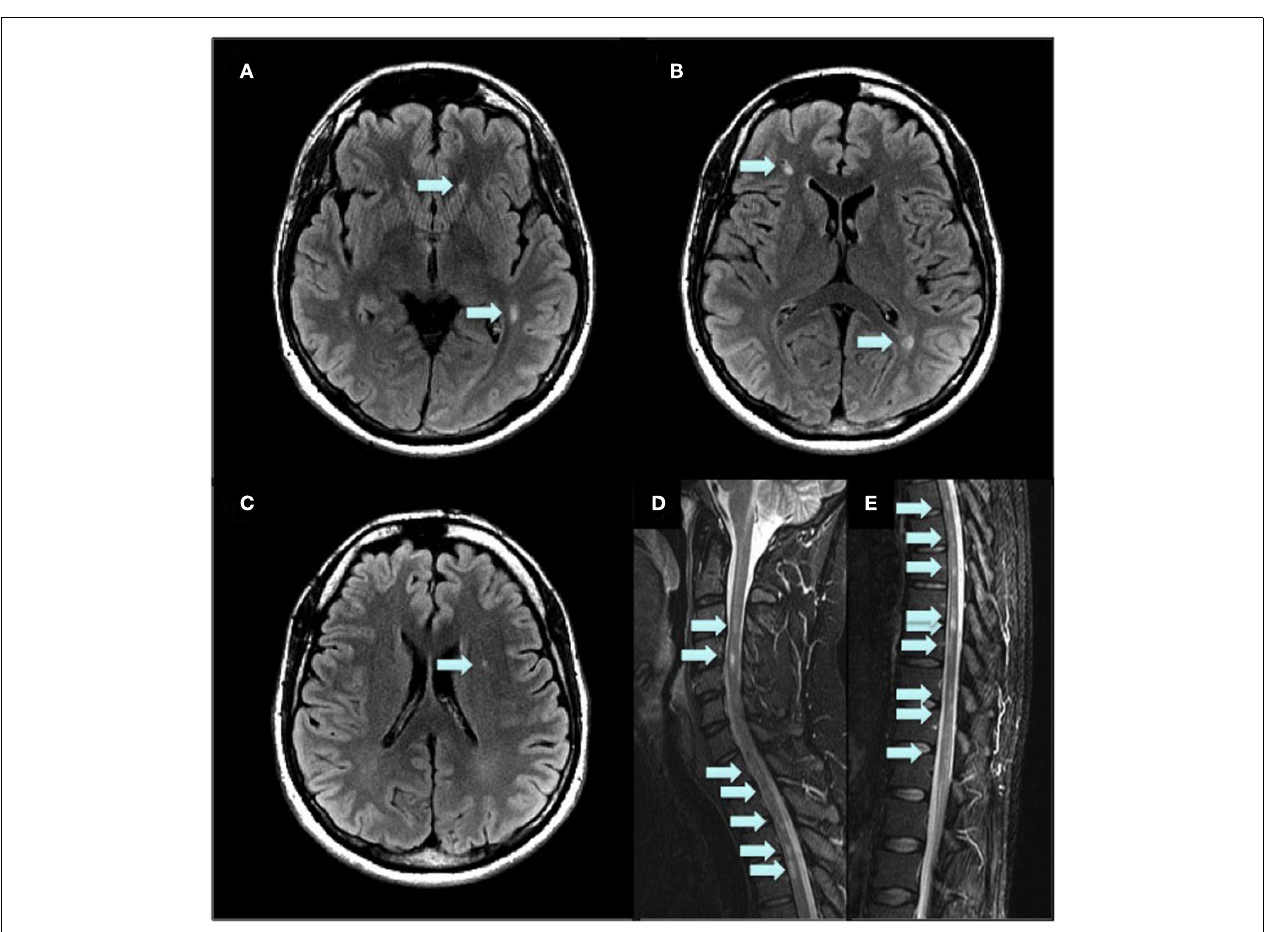
FIGURE 1 | Initial MRI 2D Flair of the brain (A–C) and FSTIR of the spinal cord (D,E) at the time of MS diagnosis. Arrows indicate MS lesions.